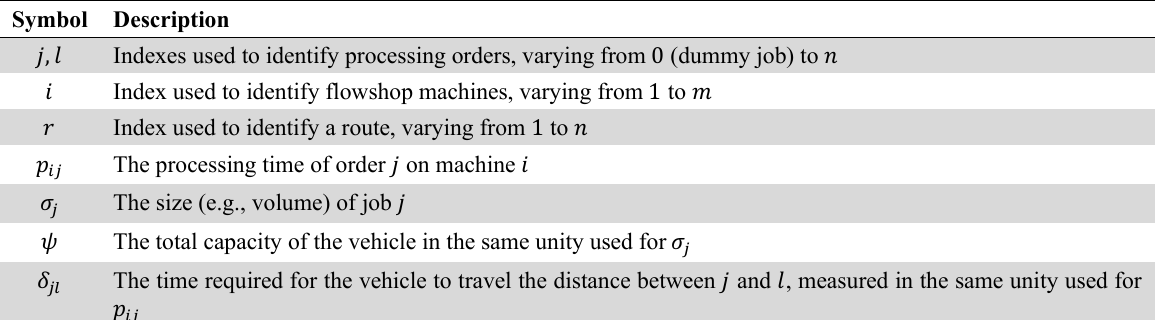
Sets and parameters used to define a problem instance